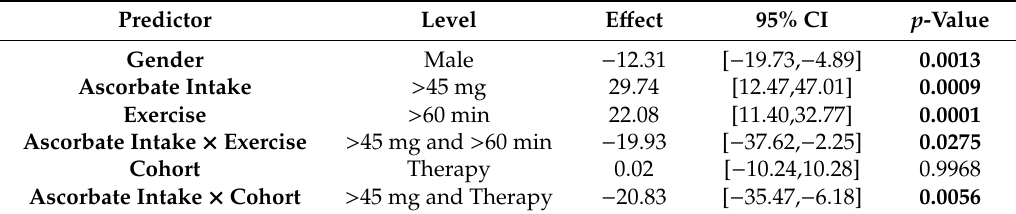
Table 4. Multiple linear regression of plasma ascorbate in fasting patients with